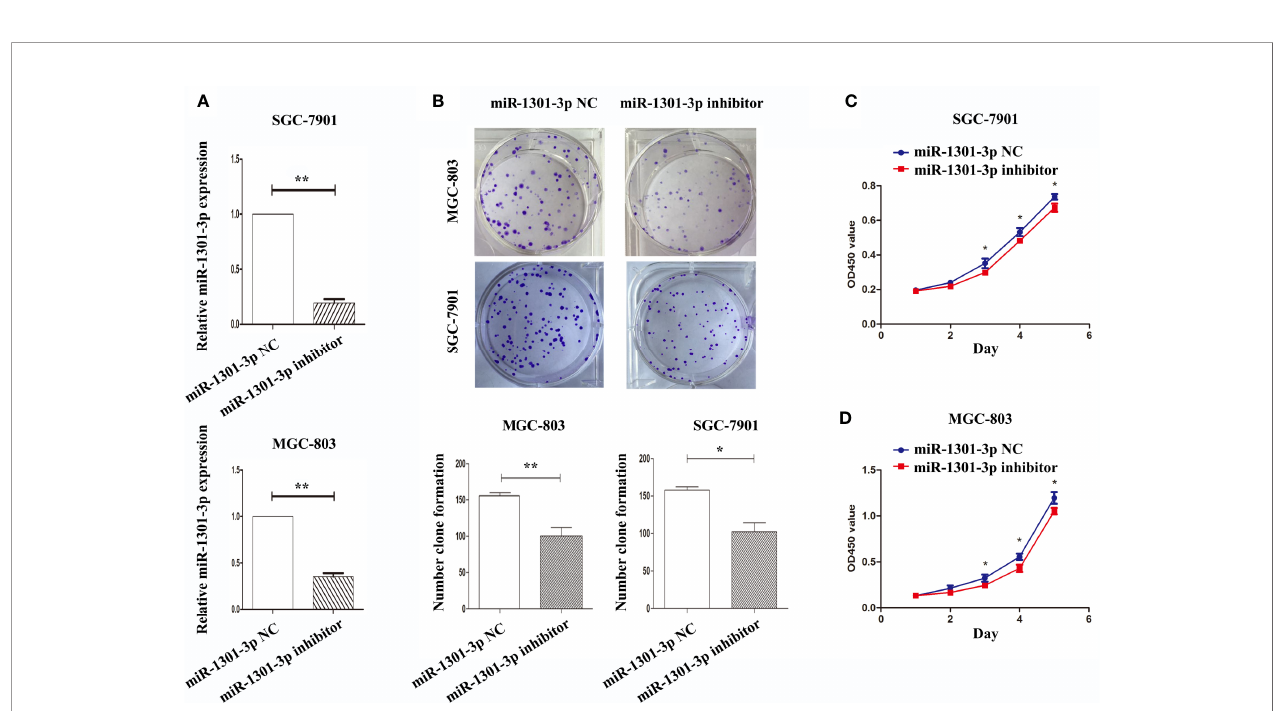
FIGURE 3 | Knockdown of miR-1301-3p inhibited the proliferation of GC cells. (A) qRT-PCR was utilized to verify the ef fi cacy of transfection. (B) Colony formation assay demonstrated knockdown of miR-1301-3p inhibited the proliferation of GC cells. (C, D) CCK-8 assay demonstrated that knockdown of miR-1301-3p inhibited the proliferation of GC cells. *p < 0.05, **p <